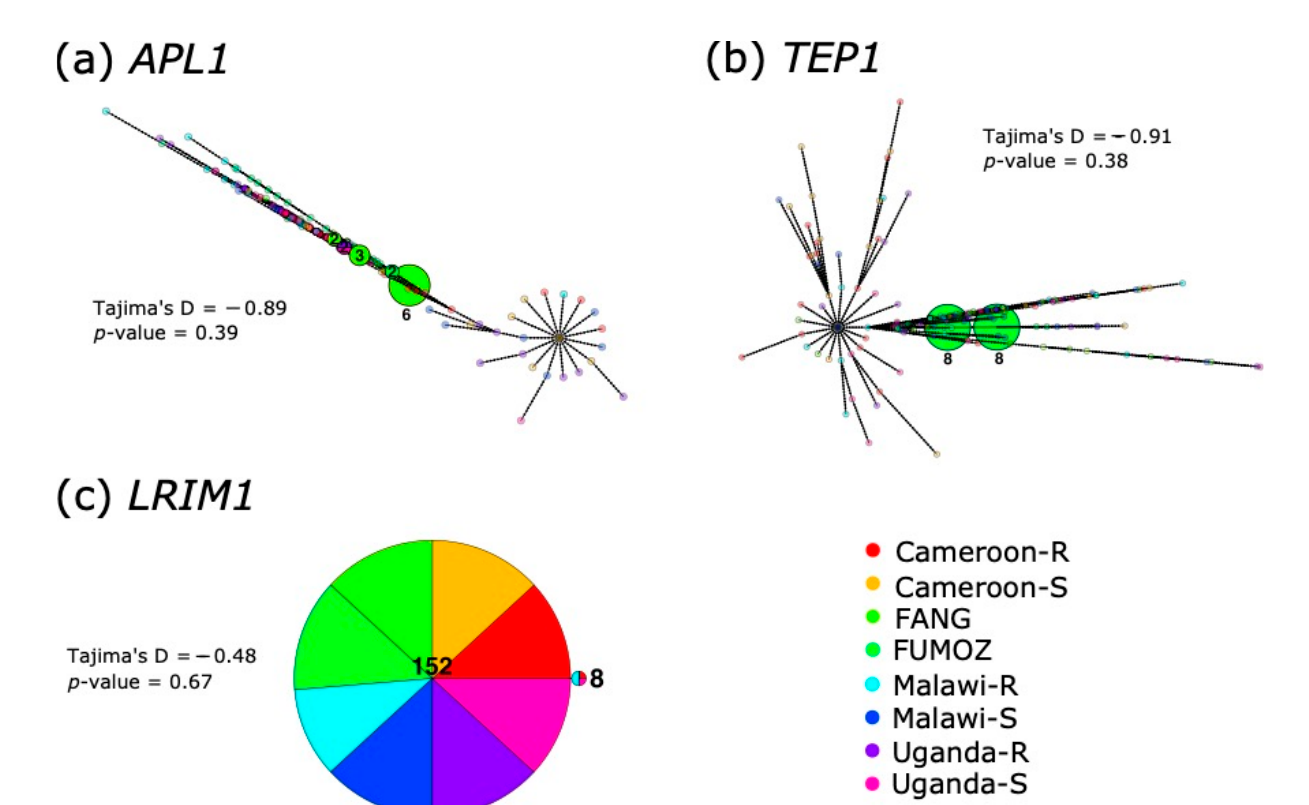
Figure 2. Haplotype networks of (a) APL1 ; (b) TEP1 and (c) LRIM1 from SureSelect data . Haplo- types are colored by origin (country or laboratory strain) and resistance (R) or susceptibility (S) of individual mosquitoes. Black circles on nodes indicate the mutational distance between haplotypes. Unique haplotypes were made translucent due to the degree of overlap along nodes. Tajima’s D and associated p -value are given for each gene adjacent to the haplotype network.